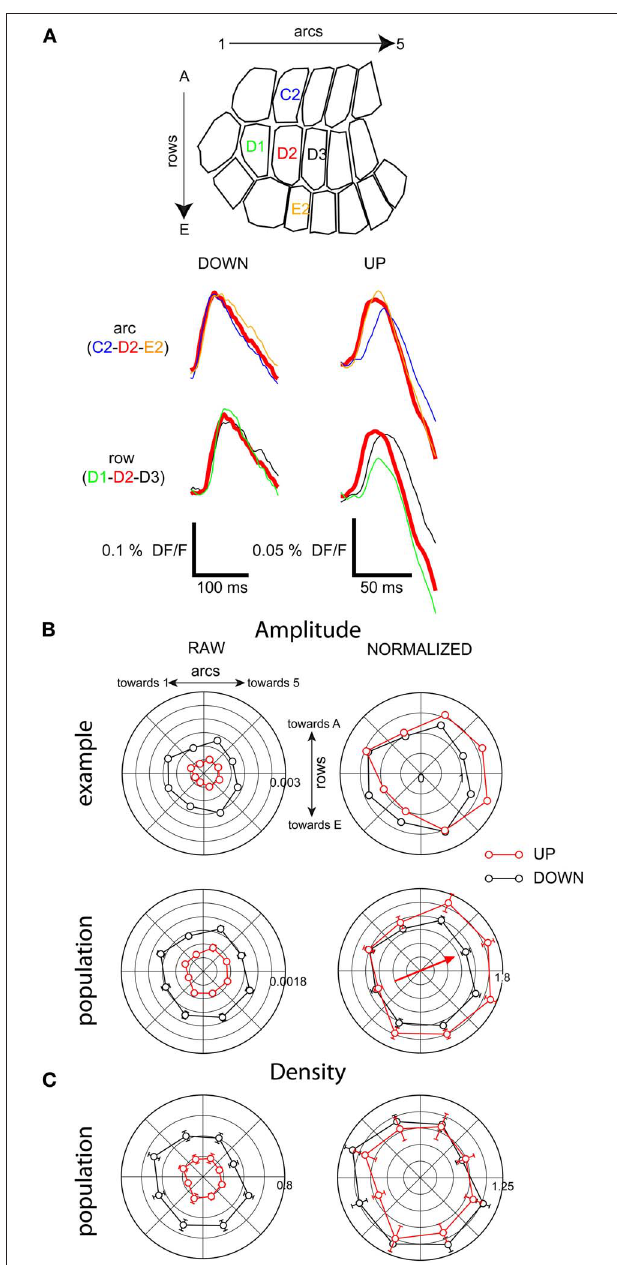
FIGURE 7 | Depolarizing response amplitude distribution is not homogeneous in the up-state. (A) Barrel-column-averaged traces from a cross-shaped subregion of the barrel field, with the stimulated whisker (D2) at the center. Top: along row-axis comparison. Bottom: along arc-axis comparison. (B) Radial plot of response amplitude; same experiment as A . (C) Population radial plot of response density.